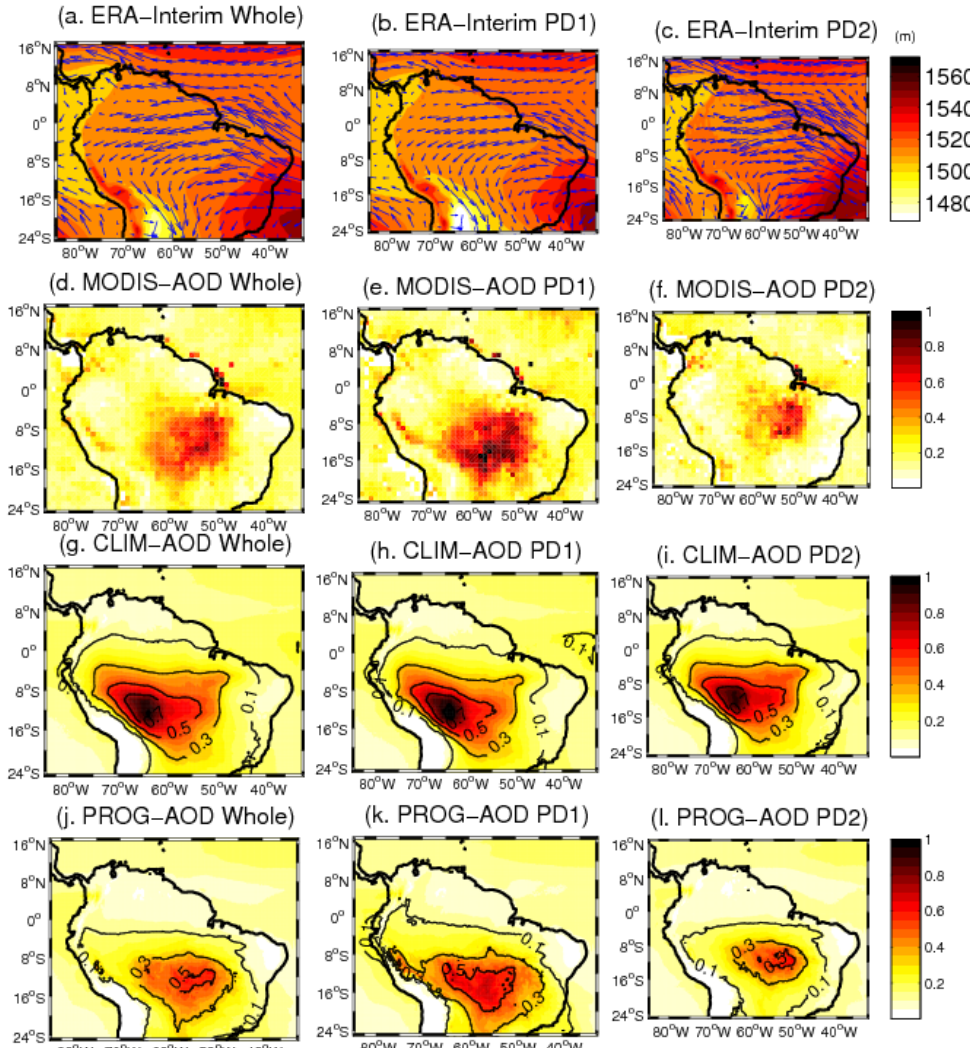
Figure 2. Geopotential height and wind vectors at 850hPa from ERA-Interim (a, b, c) and 550nm AODs from MODIS (d, e, f) , from total AOD in CLIM (g, h, i) and total AOD in PROG (j, k, l) . Plots are for whole period (a, d, g, j) , first period PD1 (b, e, h, k) , second period PD2 (c, f, i, l) . Contours show BBA